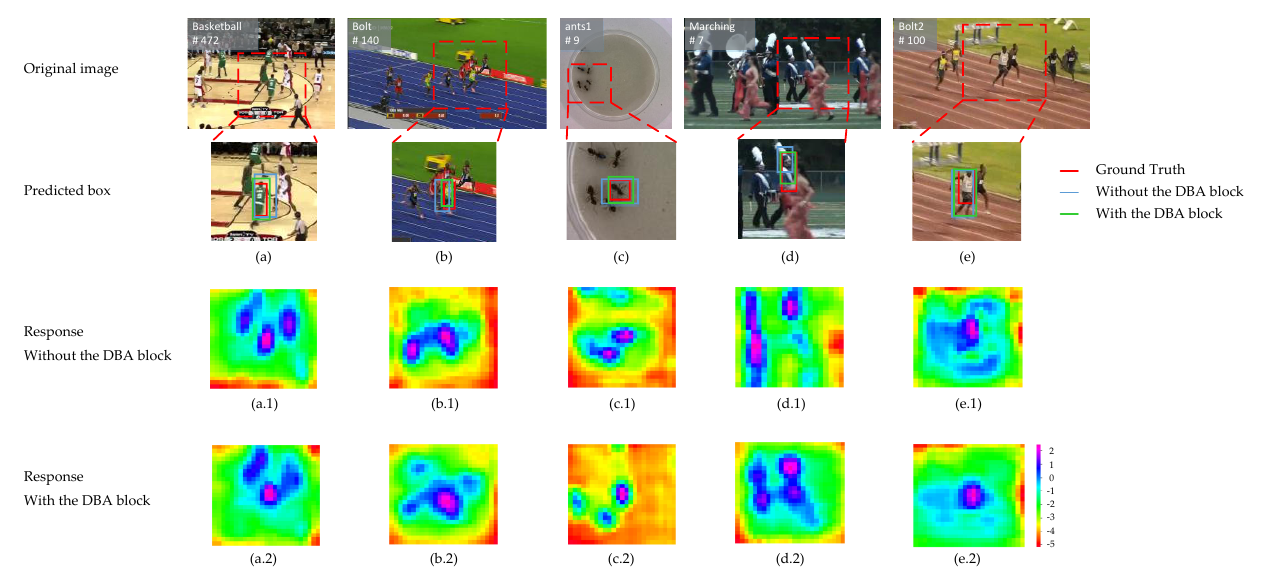
Figure 4. Response heat map of DBA-Siam without the DBA block and DBA-Siam with the DBA block in five samples. The red bounding box represents the ground truth, the blue and green bounding box respectively represents the prediction result of DBA-Siam without the DBA block and DBA-Siam with the DBA block. ( a – e ) are the search inputs of the five samples. ( a.1 – e.1 ) are the response heat maps of the tracker without the DBA block. ( a.2 – e.2 ) are the response heat maps of the tracker with the DBA block.